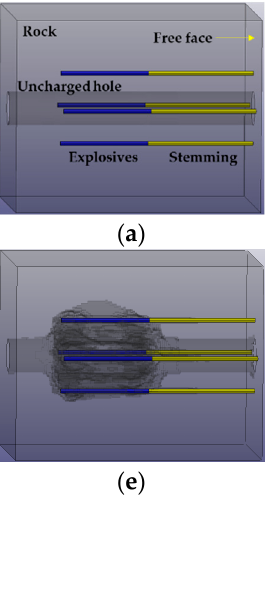
Table 4. Input parameters of the NULL model.